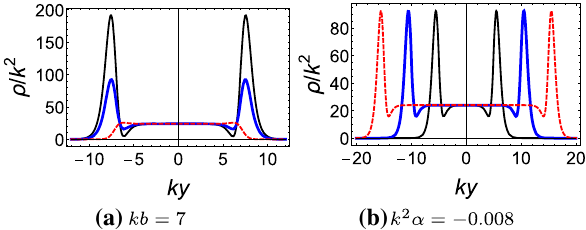
Fig. 5 The energy density of model 2. The parameter v is set to v = 1. In the left panel, we set kb = 7, and k 2 α = − 0 . 018 for the black line, k 2 α = − 0 . 008 for the thick blue line, and k 2 α = 0 . 006 for the dashed red line. In the right panel, we set k 2 α = − 0 . 008, and kb = 5 for the black line, kb = 10 for the thick blue line, and kb = 15 for the dashed red